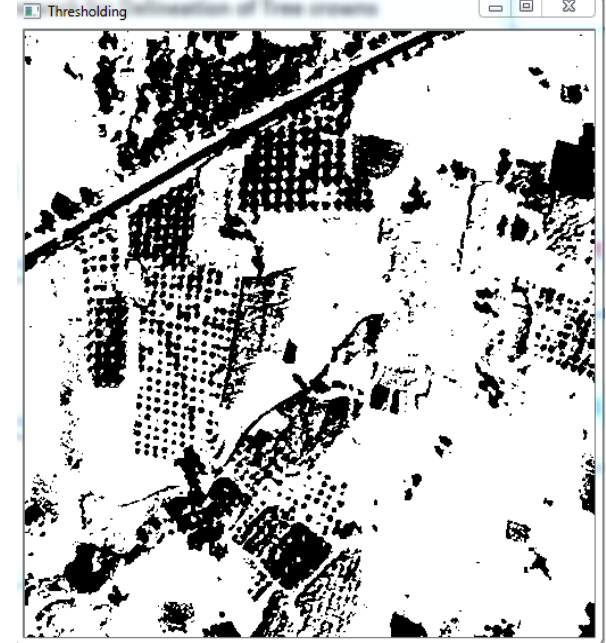
Figure 5. Enhanced Image. Figure 6. Tree Detection.